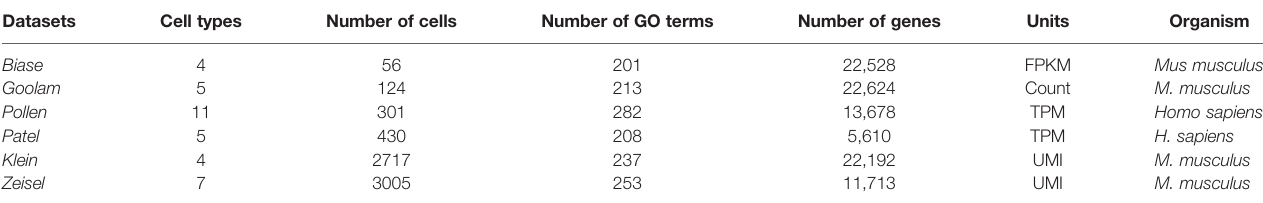
TABLE 1 | A summary of six scRNA-seq datasets used in this study.